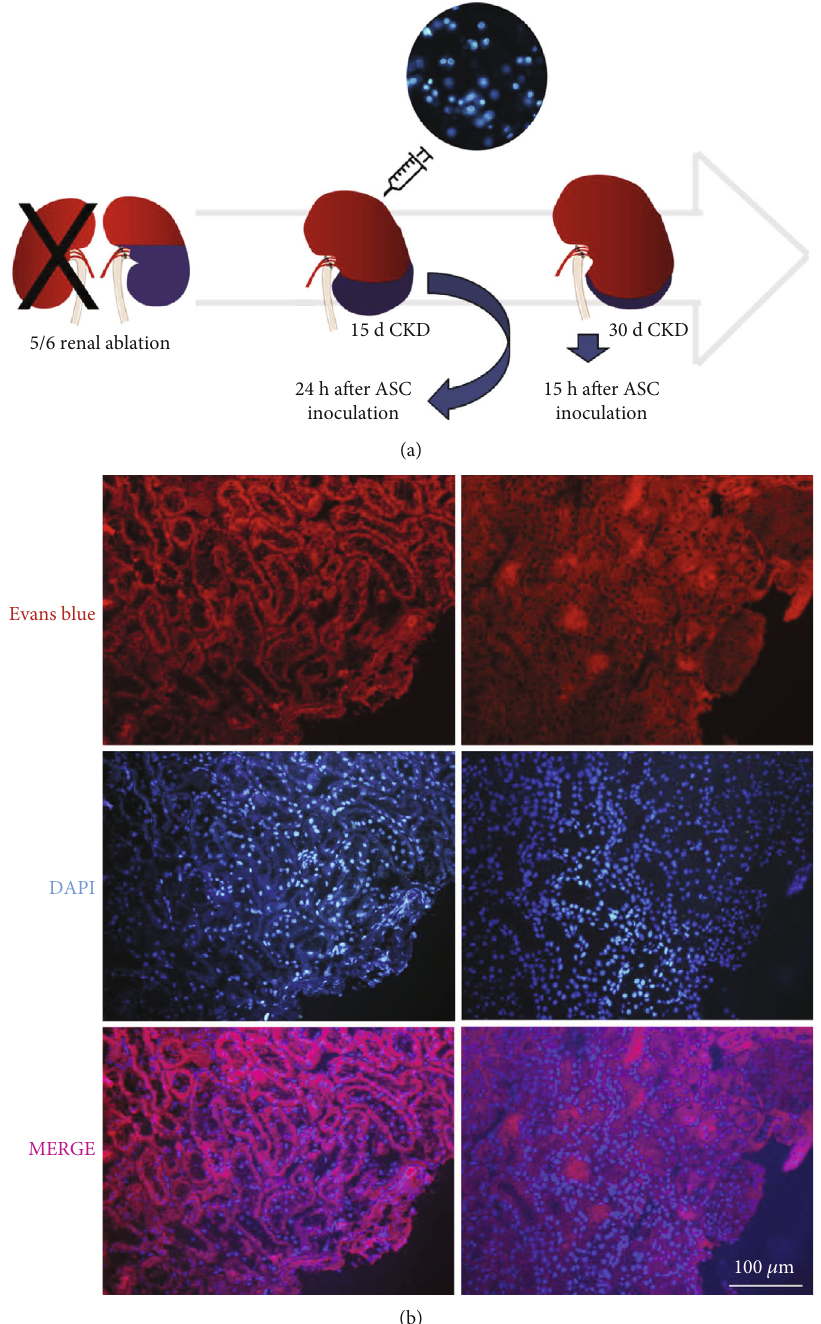
Figure 2: In vivo detection of ASC. After 15 d of CKD induction, animals received a subcapsular injection of previously DAPI-labeled ASC (a), which could be detected 24h and also 15 d after inoculation, under a fi nal 200x magni fi cation, using a fl uorescence microscope